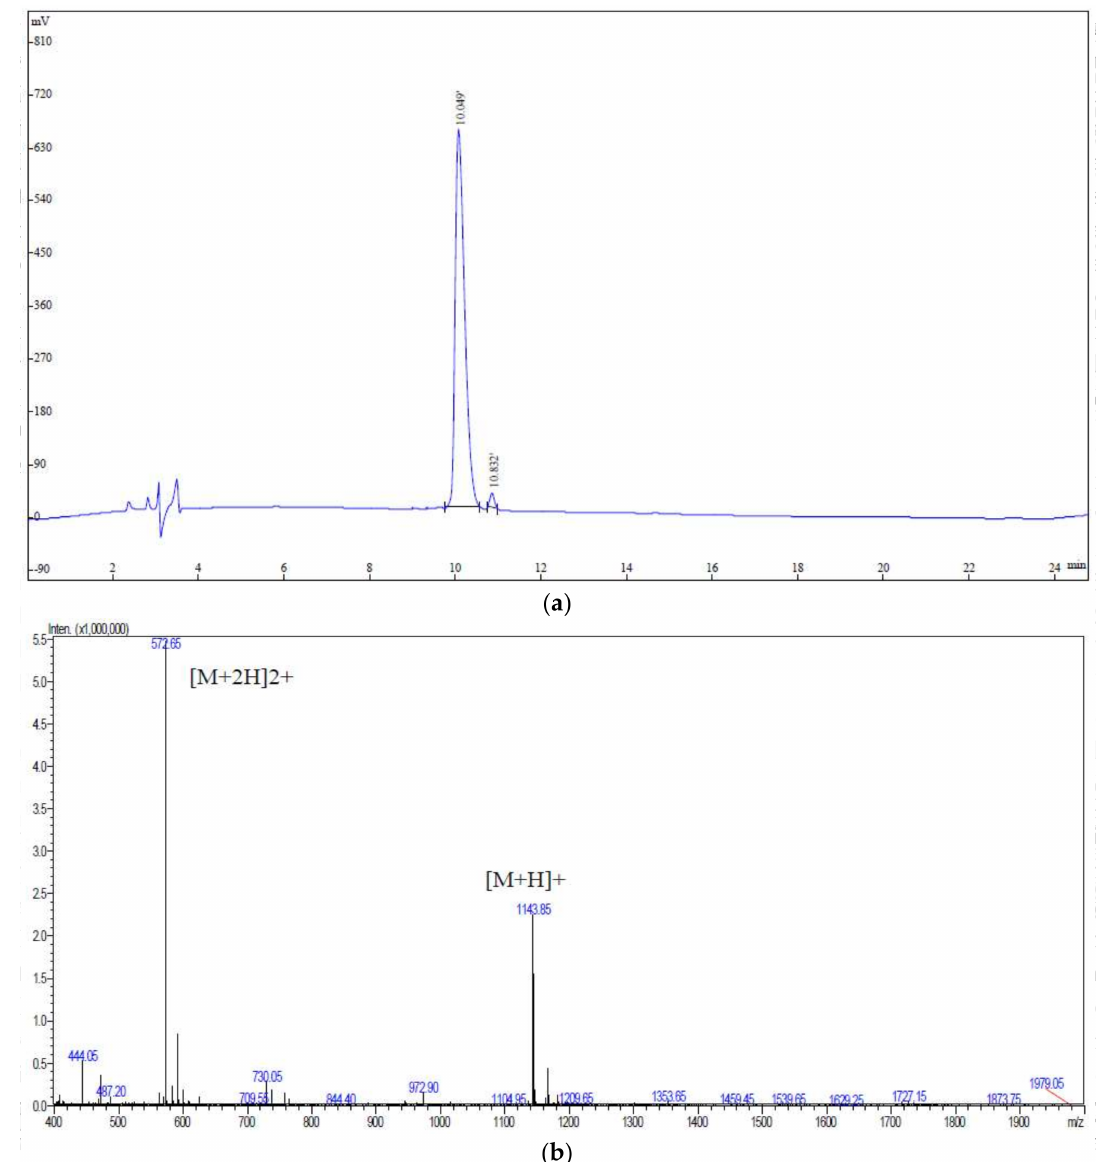
Figure 1. Identification of EPNGLLLPQY by ( a ) HPLC and ( b )